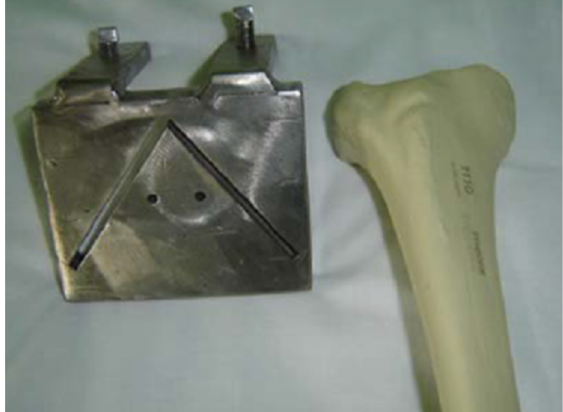
Figure 8. Guidance plate for the in vitro creation of tibial plateau fracture paths.